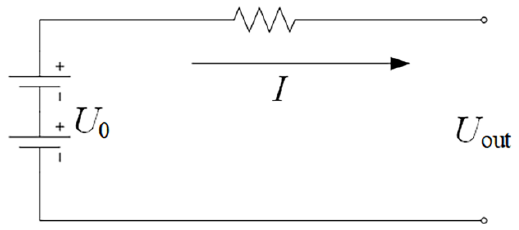
Figure 3. Equivalent circuit of the battery.